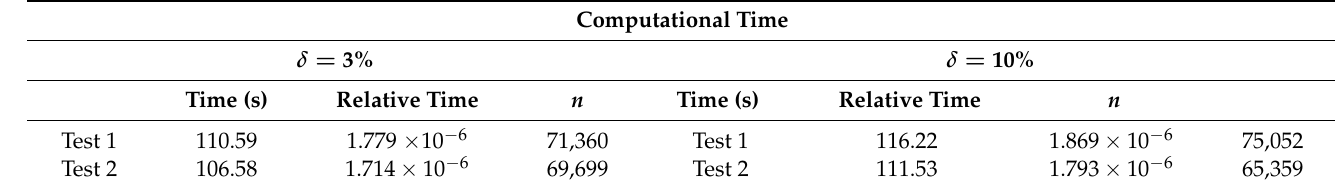
Table 4. Performance of solution of forward problem (45) in Tests 1 and 2 of Section 5 on the mesh K h 0 in terms of computational time (in seconds) and relative computational time computed by (48). Here, n is the number of the nodes on the three-times adaptively refined original coarse mesh (consisting of 63,492 nodes), which we used for the generation of transmitted